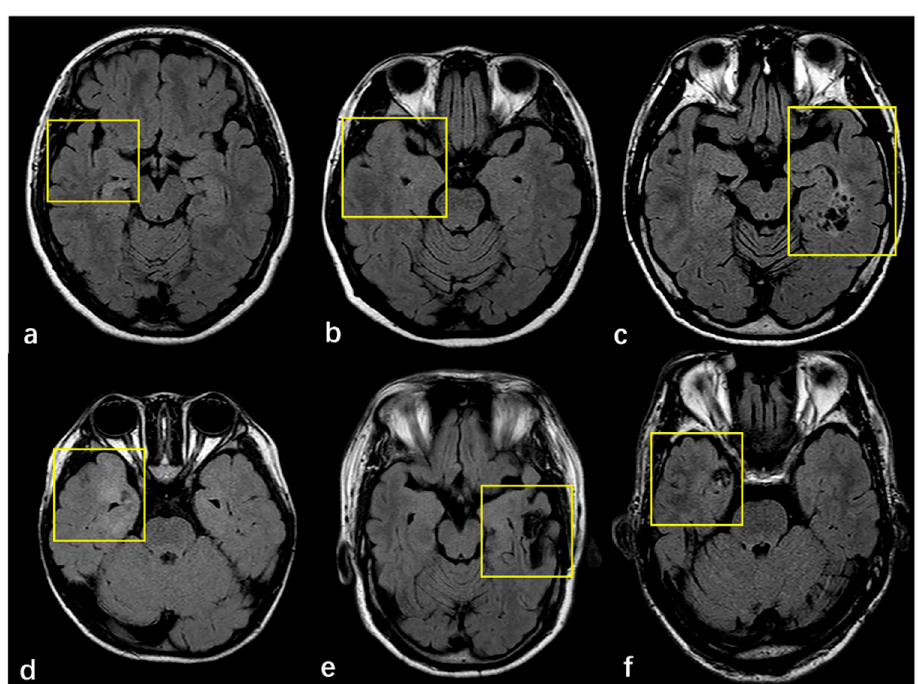
Figure 2. ( a – f ) MRI finding of adjacent cortex in patients with FCD. ( a ) Right hippocampal atrophy without visually adjacent cortex abnormality. ( b ) Right hippocampal hyperintense with the thickened cortex of ipsilateral temporal lobe. ( c ) GG is located medial to the left temporal lobe with a normal adjacent cortex. ( d ) The right temporal pole and medial temporal lobe cortex were thickened, and indistinctness of the gray–white matter junction was complicated by GG. ( e ) Right frontal AVM without visual alterations in the adjacent cortex. ( f ) There is a CCM in the right temporal lobe with adjacent cortex hyperintense and indistinctness of the gray–white matter junction.